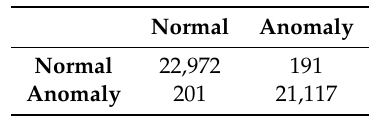
Table 35. Confusion matrix for Bagging Random Forest.